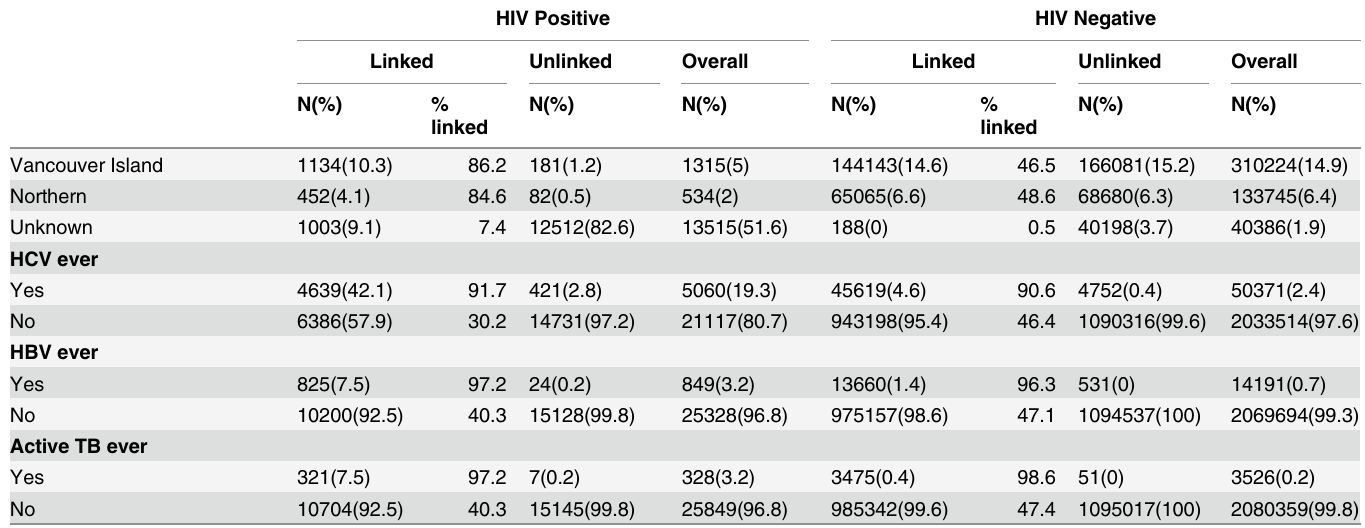
tests or HCV case definition alone, rather than the combination of anti-HCV and RNA (